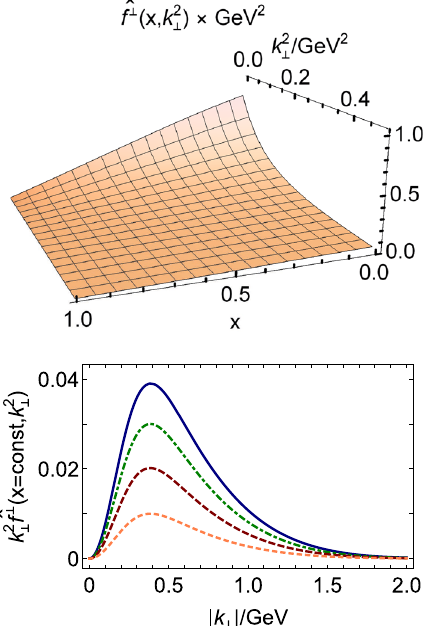
Fig. 11 Upper panel. Twist-four pion TMD, negative- f 3 ( x , k 2 ⊥ ) , Eq. (6.3). Lower panel. Negative- k 2 ⊥ f 3 ( x , k 2 ⊥ ) at: x = 0 – solid blue curve; x = 1 / 3 – dot-dashed green curve; x = 2 / 3 – dashed dark-red curve; and x = 1 – short-dashed orange curve. Scale is ζ H , Eq.